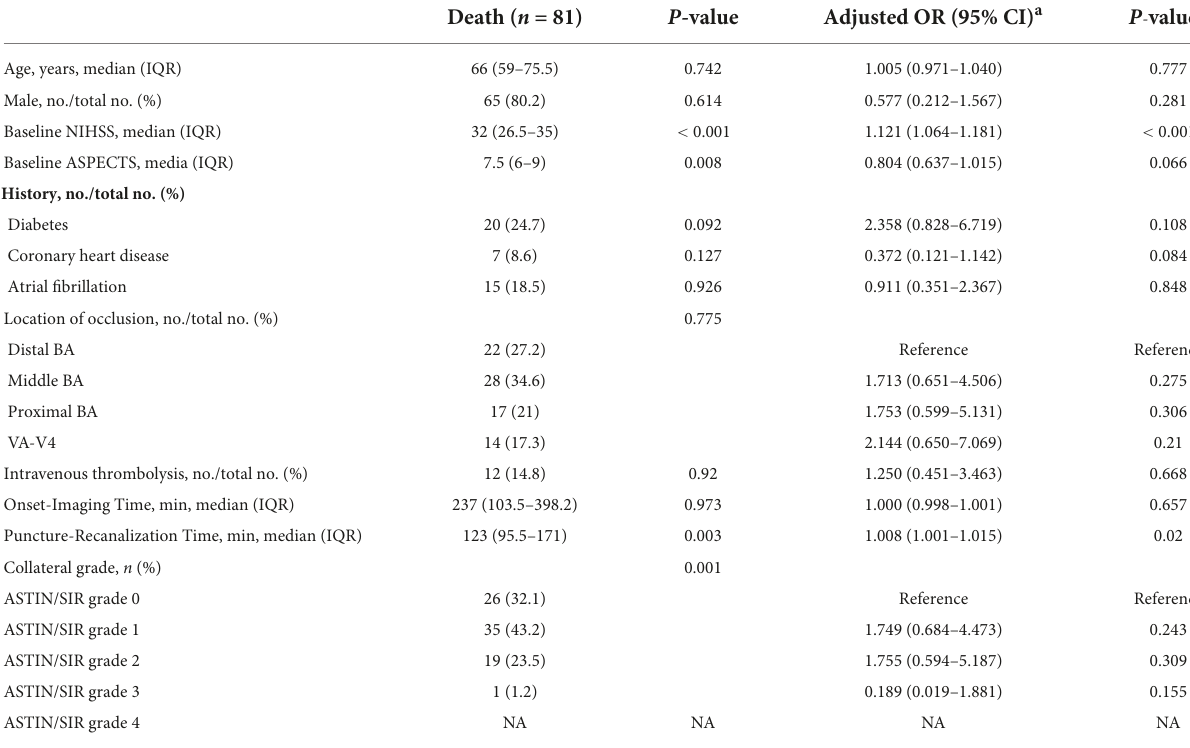
TABLE 4 Factors associated with mortality at 90 days of VBD patients.